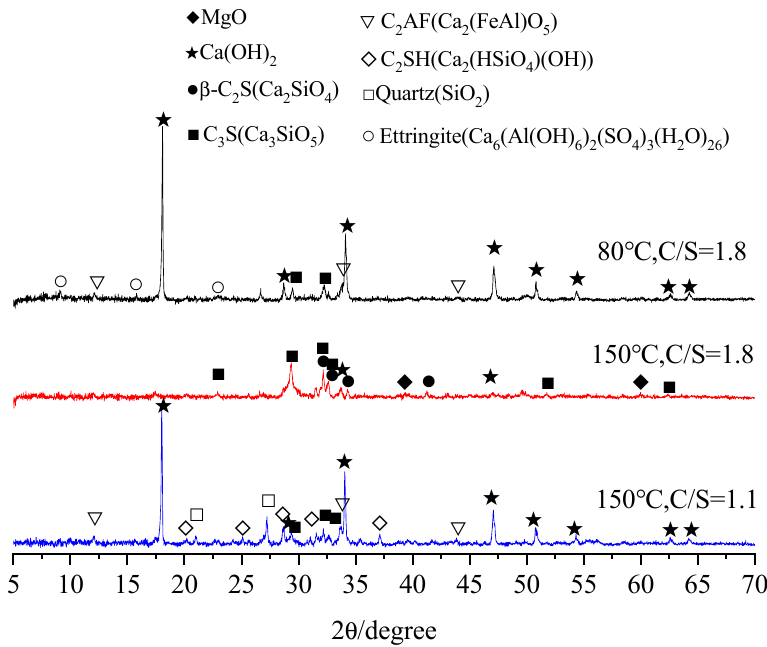
Figure 4. XRD patterns of cement under different C/S and curing conditions.